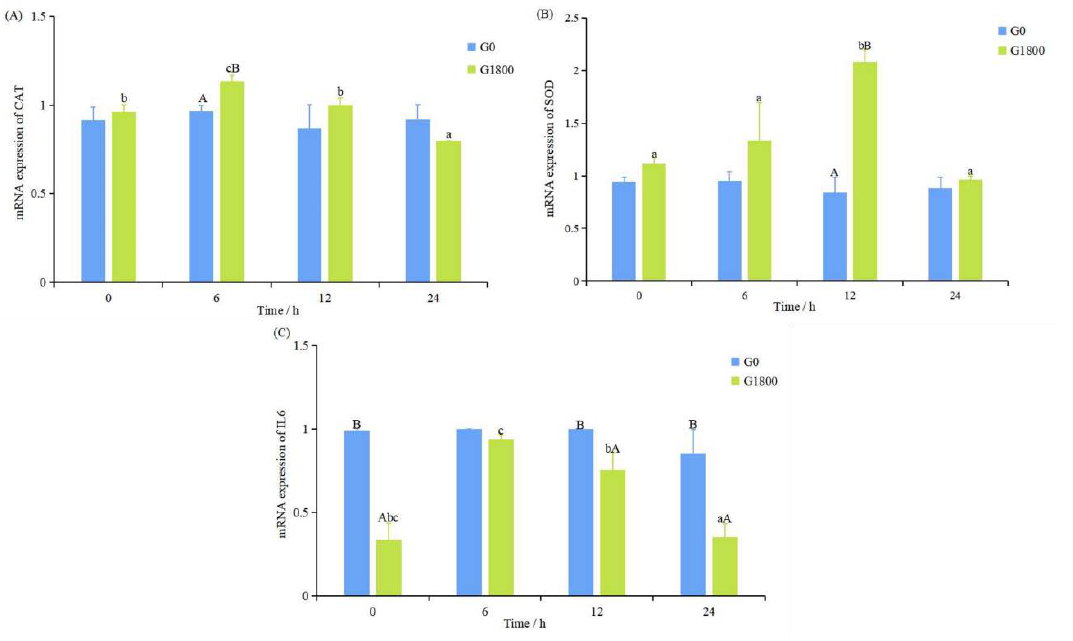
Figure 2. Effect of dietary GML supplementation on the expression of CAT ( A ), SOD ( B ), and IL6 ( C ) in grouper under salinity stress. Data represent means of three tanks in each group; error bar indicates S. D. Values with different letters are significantly different ( p < 0.05). “a, b, c” represents the significance between the same group at different times; “A, B” represents the significance be- tween different groups at the same time period. CAT: superoxide dismutase; SOD: superoxide dis- mutase; IL6: interleukin 6.